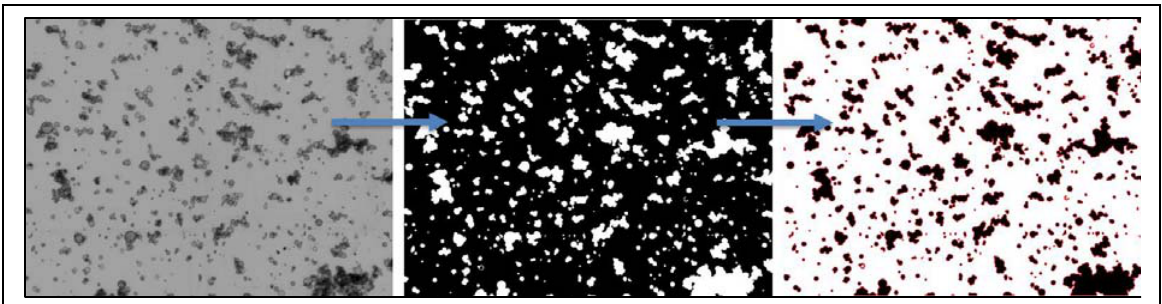
Figure 3. (Left) Raw Image; (Middle) Binary Image; (Right) Counted Particles.